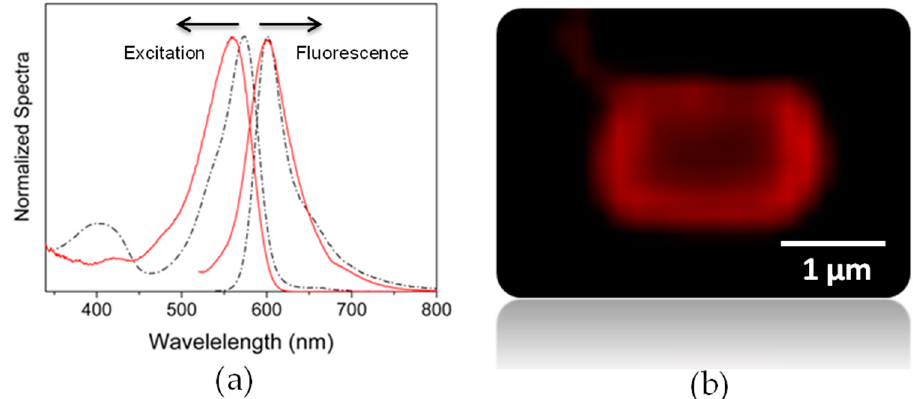
Figure 7. ( a ) Normalized excitation and emission spectra of the BODIPY stopcock grafted to disc-shaped LTL zeolite crystals (solid) and free in toluene (dash dotted); ( b ) Fluorescence microscopy image of a single microsized LTL crystal functionalized with the BODIPY stopcock.